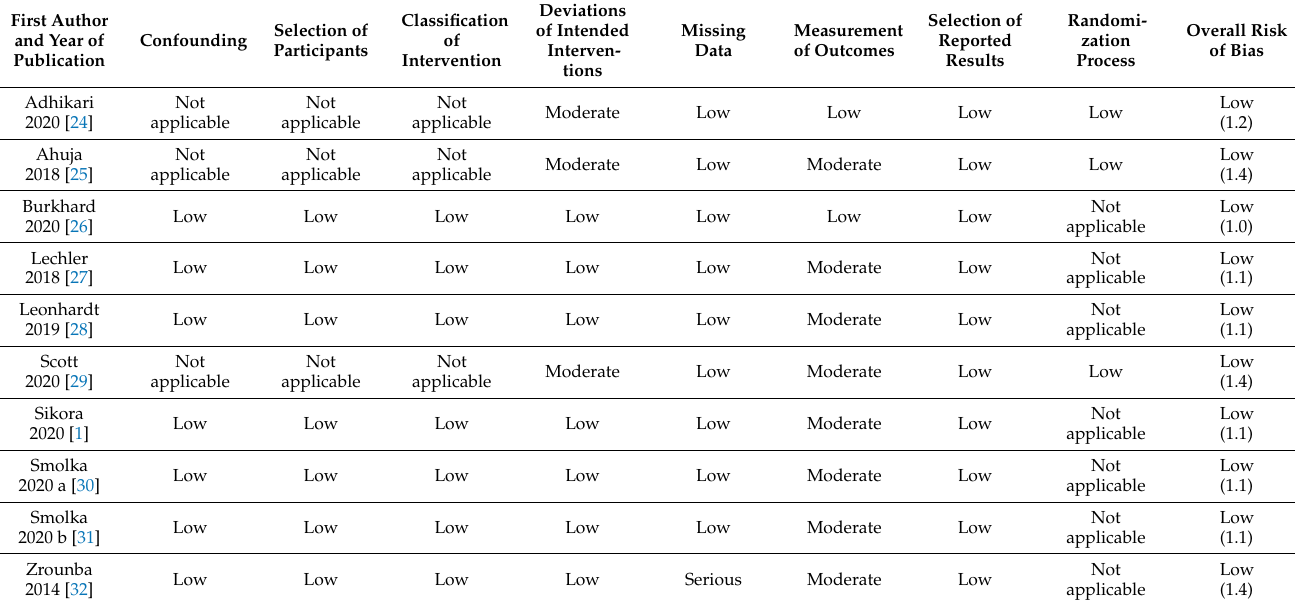
Table 2. Bias risk assessment for included studies [22,23].